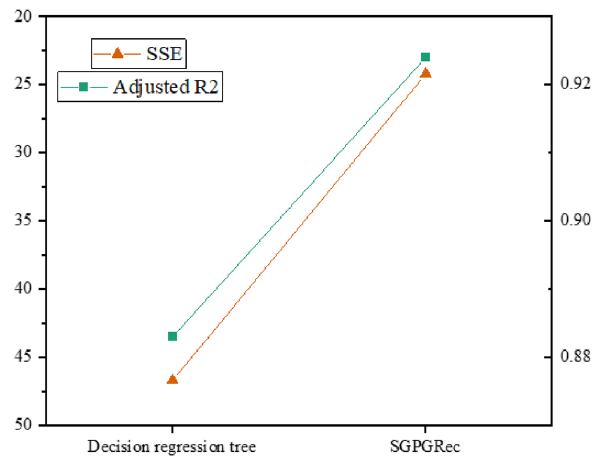
Figure 6. The performance of case workload prediction.